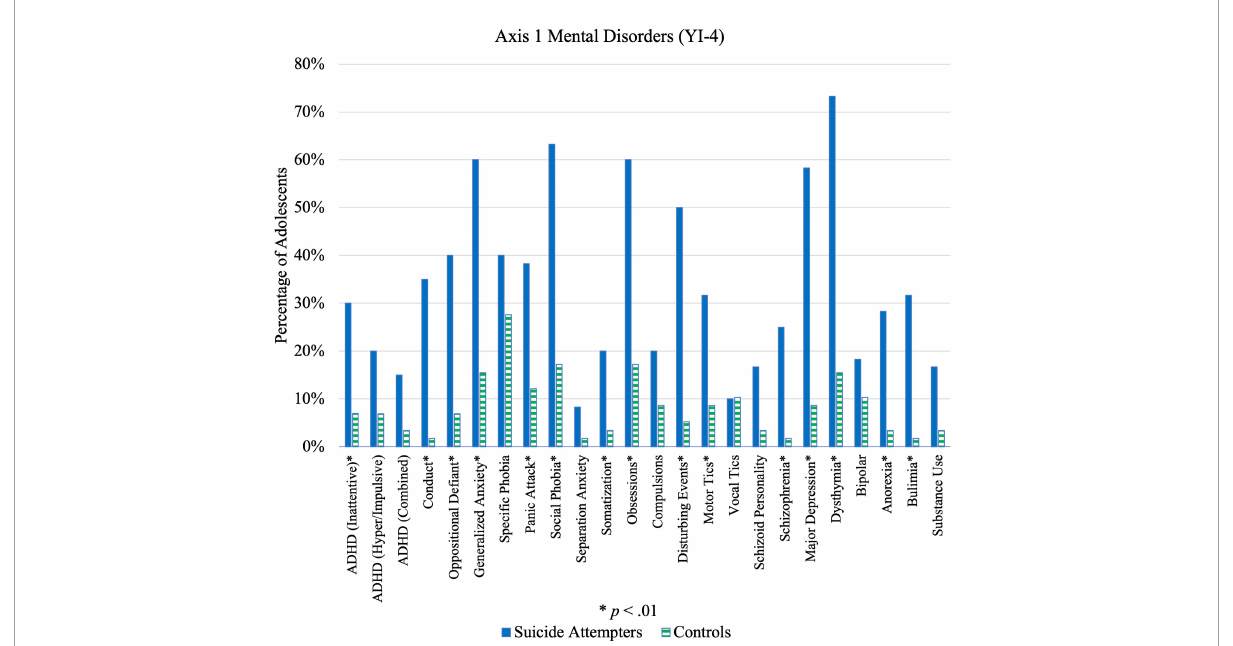
FIGURE4 Illustration of differences in Axis 1 mental disorders between suicide attempters and control